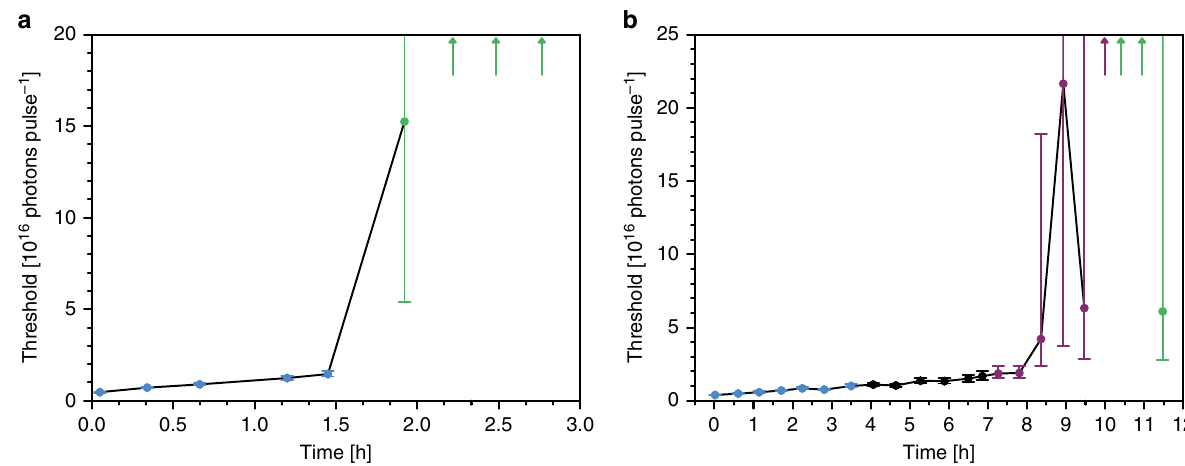
Fig. 5 Step-changes in the threshold point in response to ligand-binding. In two further experiments in R2, the threshold behaviour of dye-labelled M13 was monitored as a function of time and the addition of cp-mAb or a non-binding antibody. For each experiment, the data were fi t globally using equation (26) with parameters χ 0 and χ 1 shared between each set of threshold measurements. For further experiment 2, 20 pmol mL − 1 V2 contained no antibody (blue), before 4.5 pmol mL − 1 cp-mAb was added (green). For further experiment 1, 23 pmol mL − 1 V2 initially contained no antibody (blue), 91 fmol mL − 1 mouse IgG2a isotype control was added (black) and then cp-mAb was added in two steps so that the concentration of cp-mAb was initially 91 fmol mL − 1 (purple) and then increased to 1.9 pmol mL − 1 (green). See Methods for more details. The threshold points derived from the fi tted models have been plotted against time for, a further experiment 2 and for, b further experiment 1. Measurements have been represented by an arrow if the fi tting implied that the sample could no longer sustain lasing. The error bars represent standard errors and the error bars that extend beyond the upper limit of the y-axis extend to in fi nity. See Supplementary Fig. 10 for an expanded version of this fi gure with the intensity against pump energy data for different points in the time series. Source data are provided as a Source Data fi